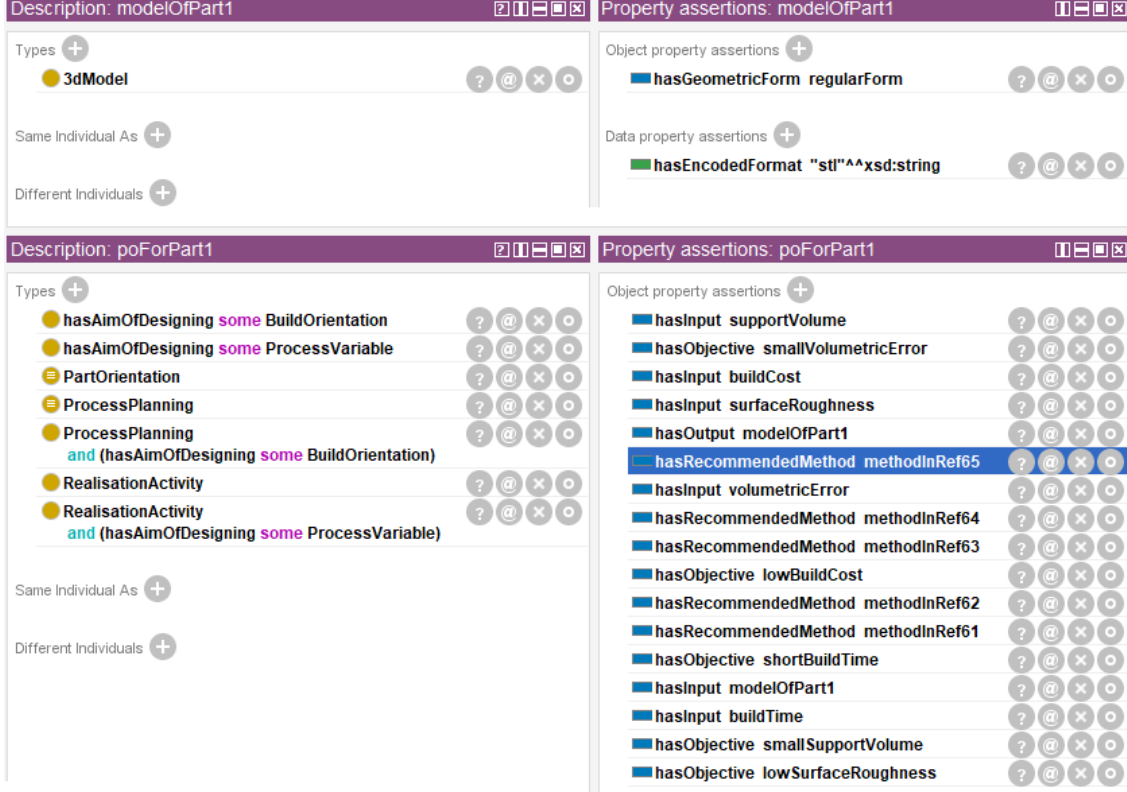
Figure 9. Assertions and reasoning results of part orientation for the LPBF